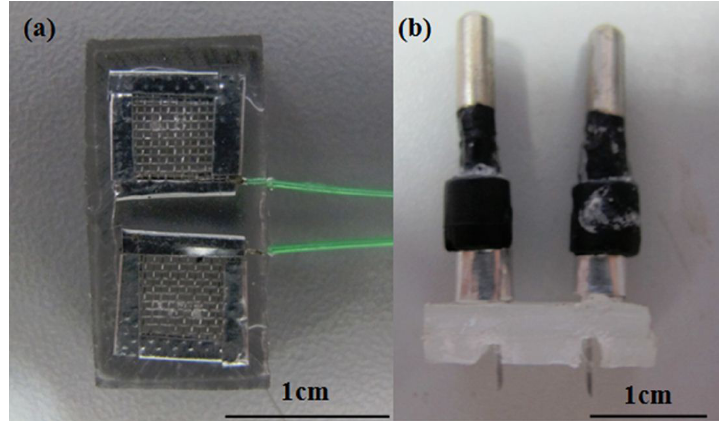
Figure 4. The fabricated device. ( a ) The fabricated socket with two pieces of stainless steel net inside. ( b ) The fabricated plug with two needles.